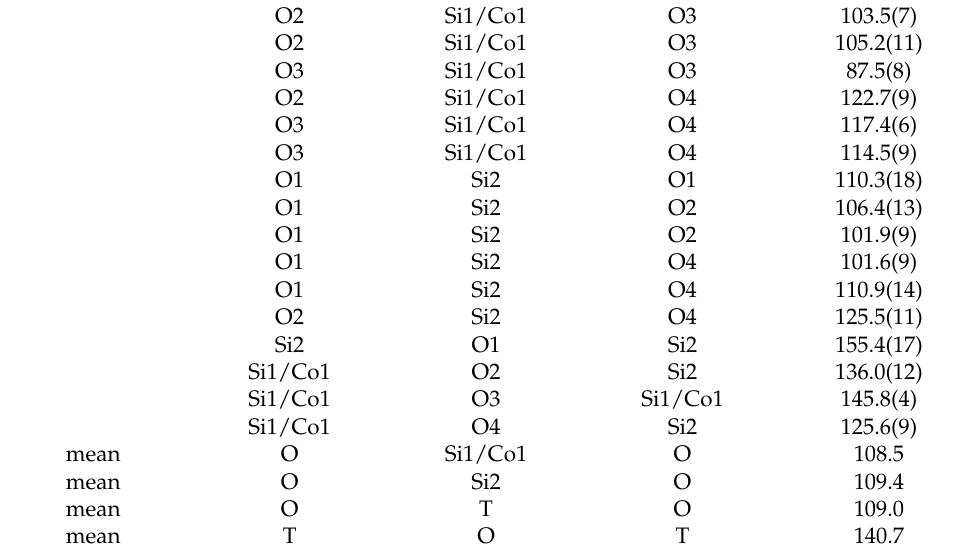
Table 7. Refined interatomic angles ( ◦ ) for 1133 K Rb 2 CoSi 5 O l2 . T = Si or